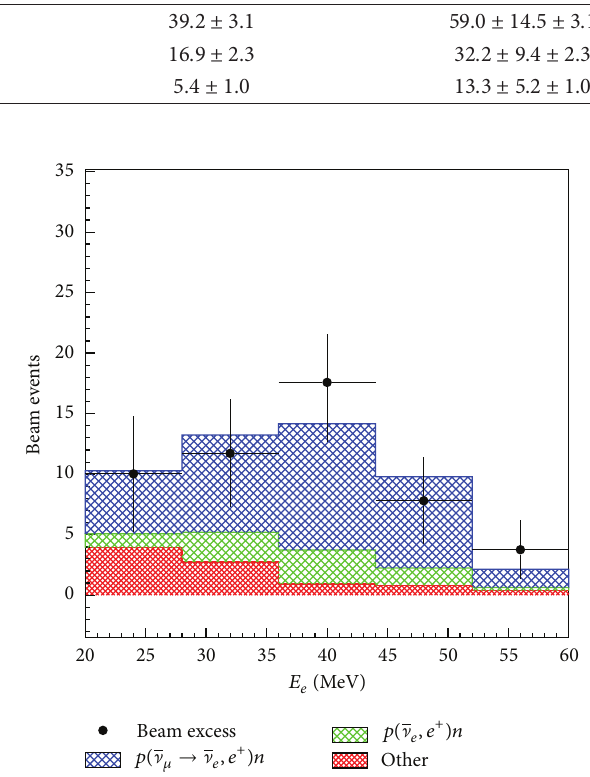
Figure 5: The LSND electron energy distribution for events with > 10 . The shaded region shows the expected distribution from 𝑅 𝛾 a combination of neutrino background plus neutrino oscillations at low Δ𝑚 2